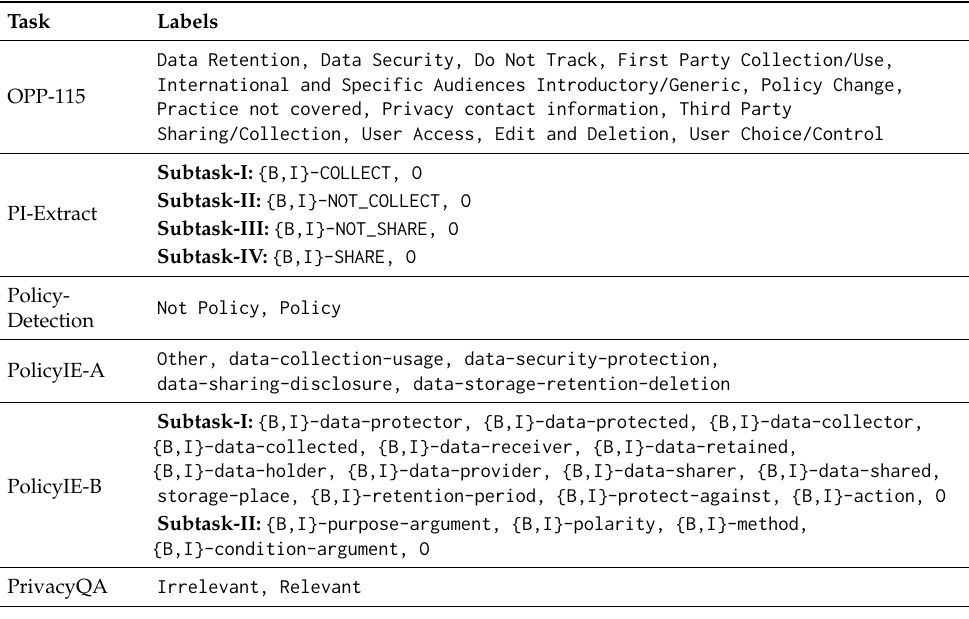
Table A1. Breakdown of labels for each PrivacyGLUE task; PolicyQA is omitted from this table since it is a reading comprehension task and does not have explicit labels like other